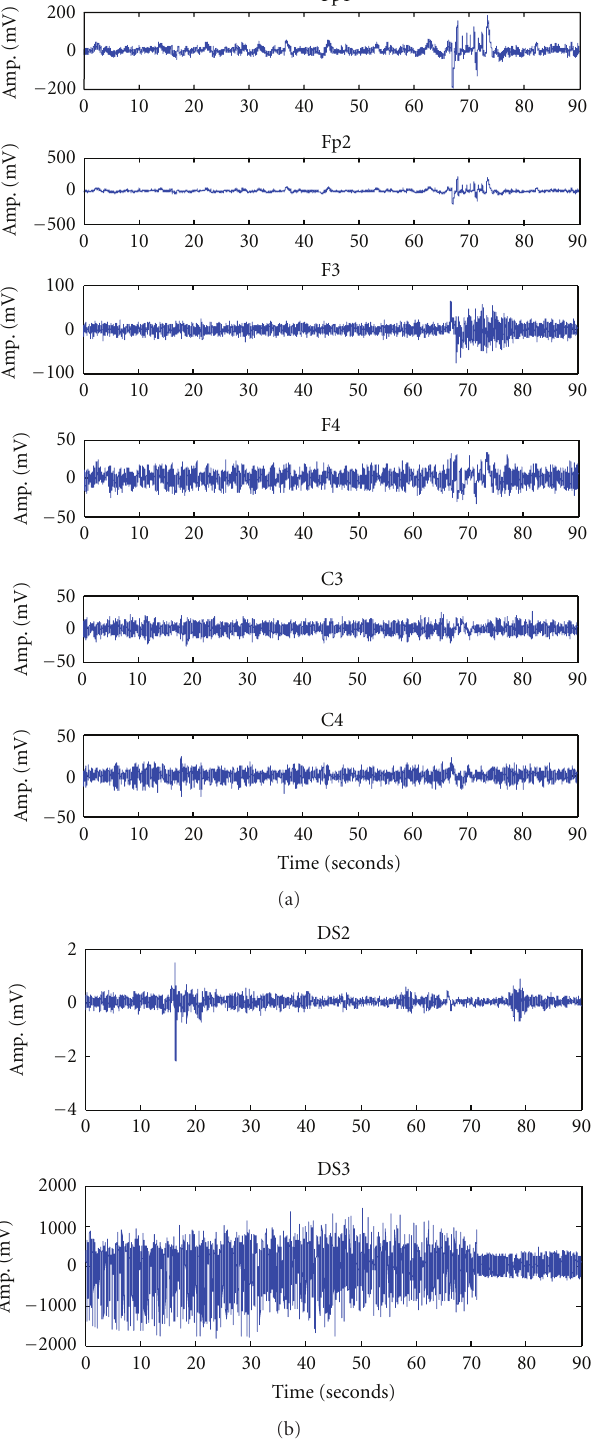
Figure 5: Recordings of di ff erent EEG signals: (a) epileptic with sudden seizure and (b) normal and pure epileptic signal.